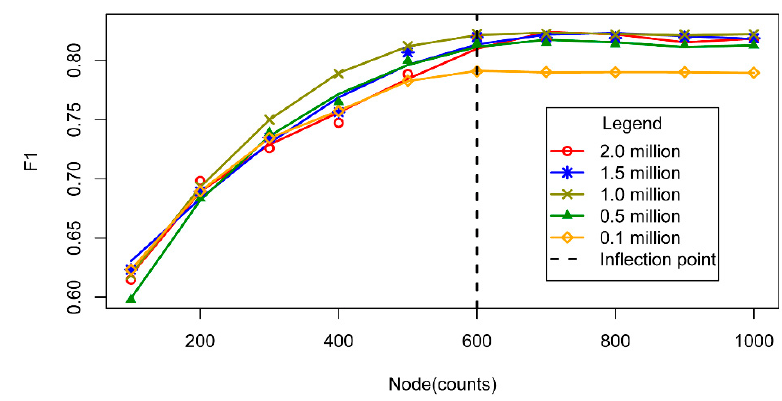
Figure 9. The relationship between the number of nodes in each layer and F1 values.